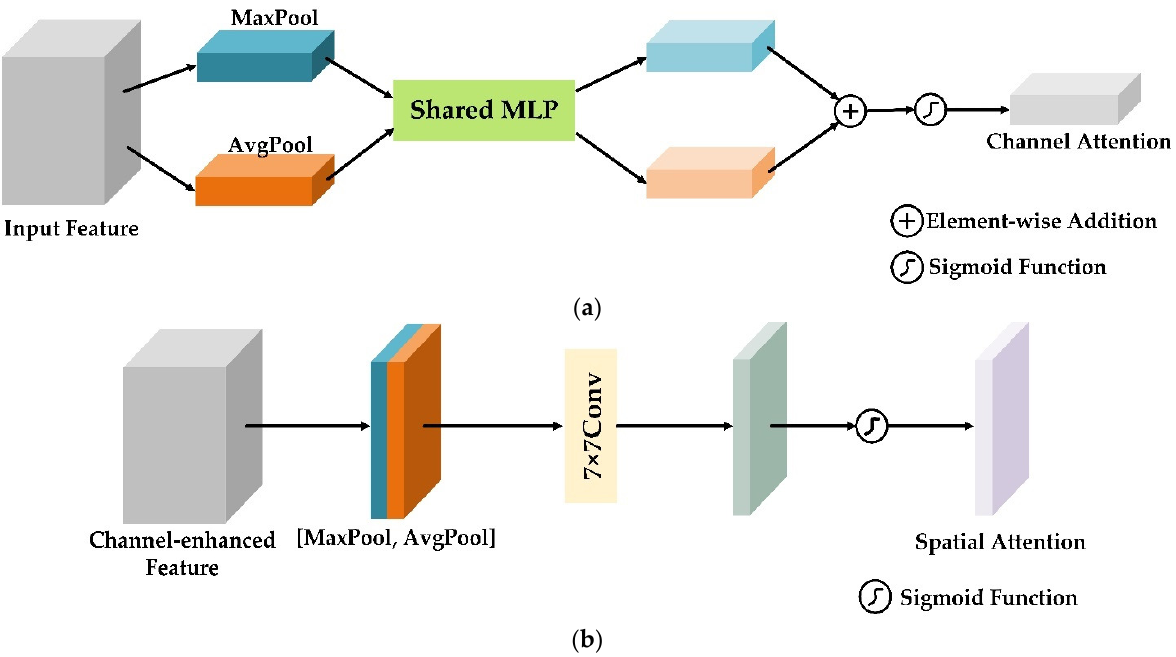
Figure 4. The structure of channel attention module and spatial attention module. ( a ) The channel attention module. ( b ) The spatial attention module. The channel attention module helps focus on the meaningful channels, while the spatial attention module contributes to extracting features at the location of interest.